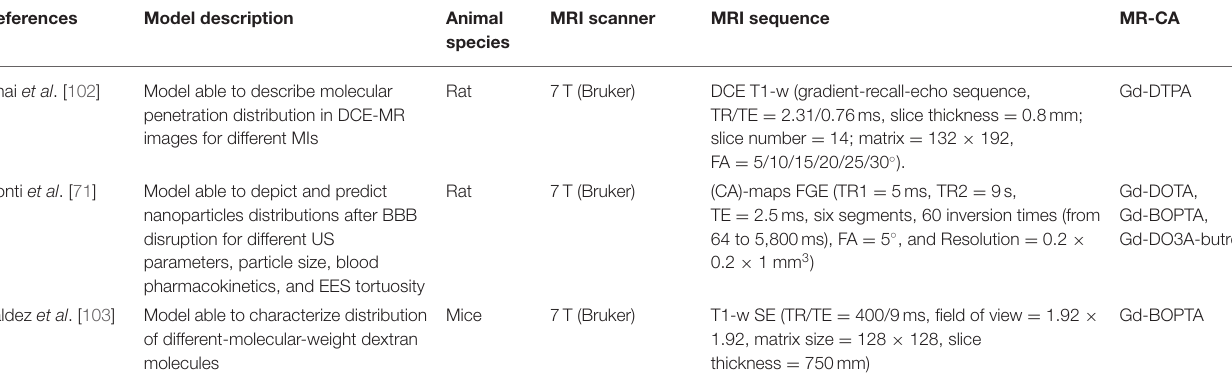
TABLE 3 | Specifications of studies, included in this narrative review, using MR-CA administration to validate models able to depict particles distributions within the brain after FUS-induced BBB opening